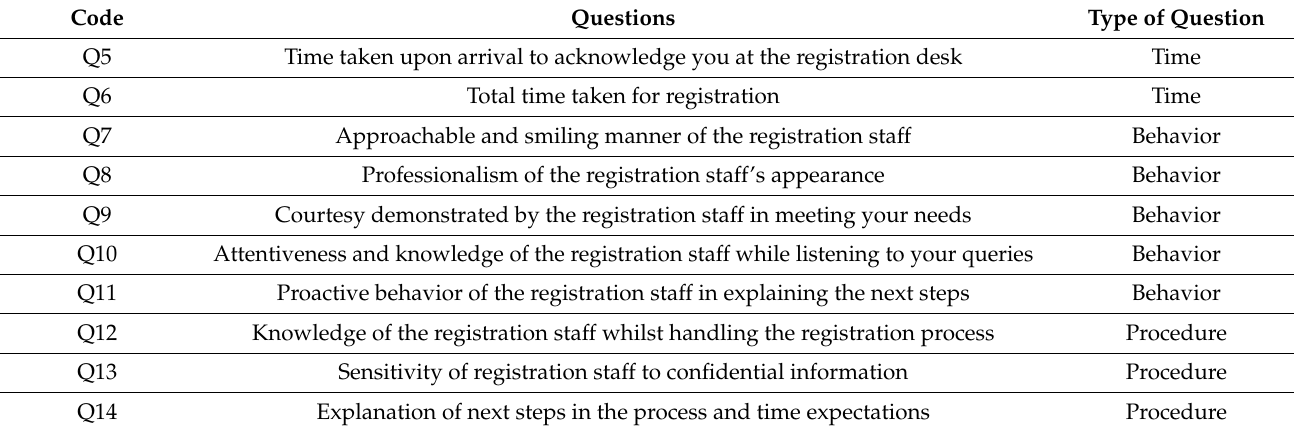
Table 2. Registration-specific questions in the survey.